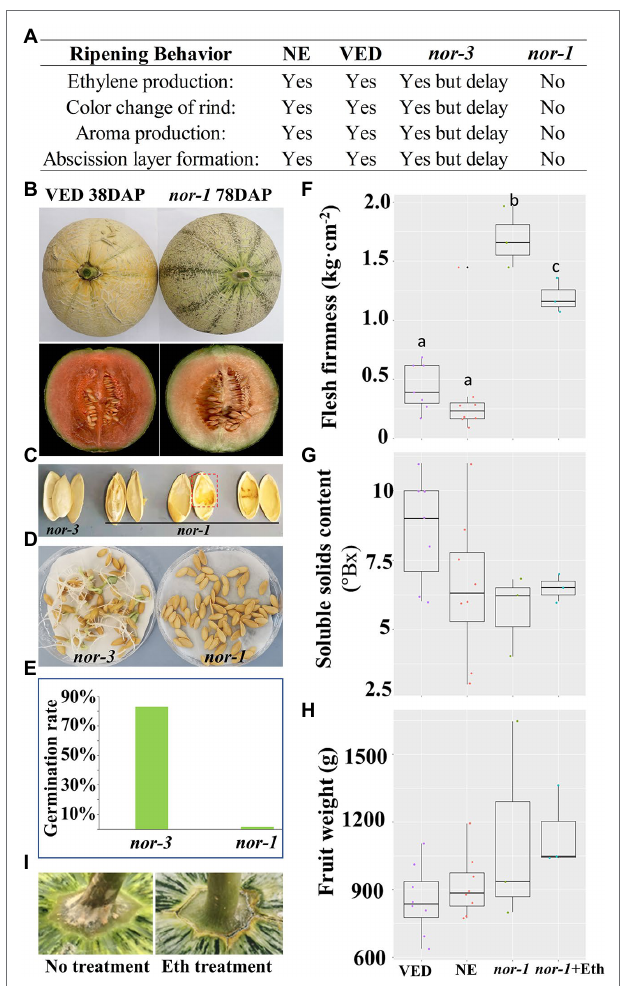
FIGURE 4 | CmNAC-NOR knock out in nor-1 blocks climacteric ripening. (A) Difference of ripening behavior among NE, VED, nor-3, and nor-1 . (B) Fruit rind and flesh of VED and nor-1 under natural ripening conditions. (C) Phenotypic comparison of seeds of nor-3 and nor-1 at 38 and 78 DAP, respectively. (D,E) Germination efficiency of nor-3 and nor-1 seeds. (F-H) Phenotypic comparison according to flesh firmness (F) , soluble solids content (G) , and fruit weight (H) between NE, VED, and nor-1 . nor-1 + Eth: nor-1 fruit after ethylene treatment. (I) Abscission layer of nor-1 appears after ethylene treatment. Lower case letters indicate significant differences ( p < 0.05, n >